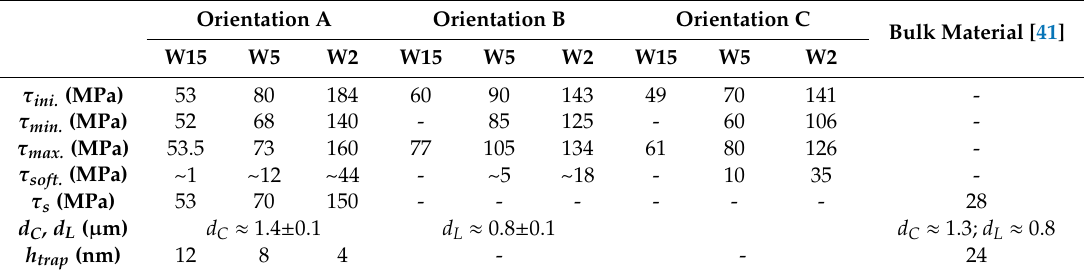
= | τ τ | : Softening stress; τ 4 cycles; τ s. : Saturation stress; d C soft. ini. - min.